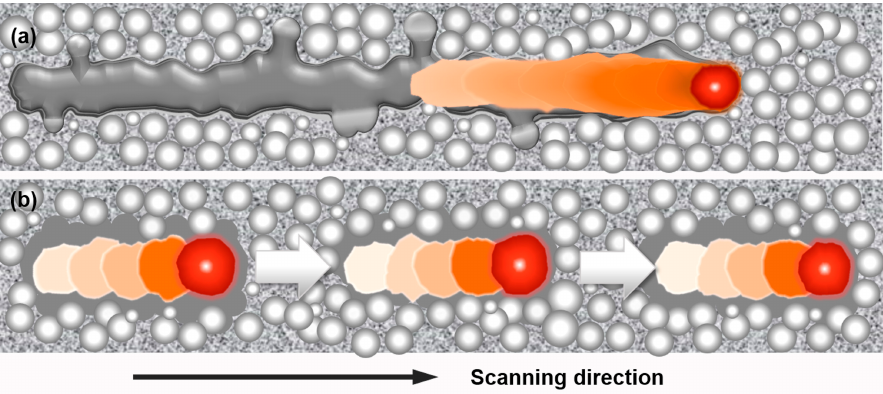
Figure 1. Illustration of ( a ) EBM system; ( b ) sample locations (each color indicated one sample); and ( c ) the picture of the EBM-built sample with dimensions (in mm). The thick arrow indicated the build direction and the thin arrows indicated the directions of the surface roughness measurements.